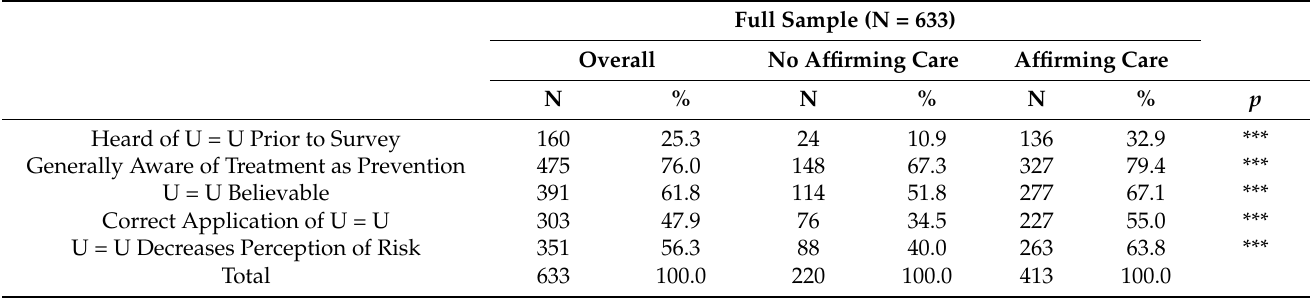
Table 3. Characteristics of midlife and older gay and bisexual men in the US south by HIV status,